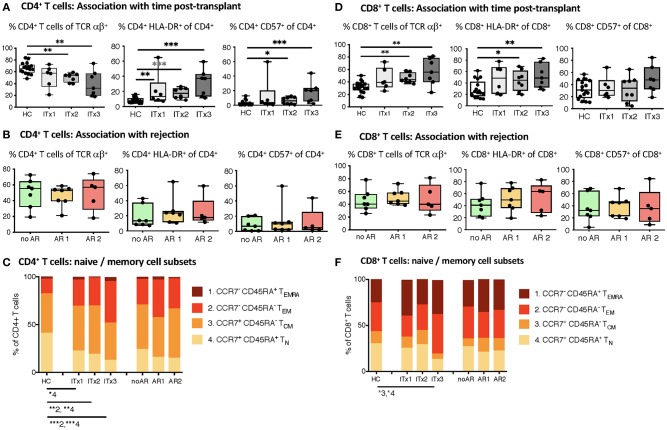
Comparative analysis of αβ T cell memory differentiation and expression of activation markers measured by flow cytometry. Shown are proportions as boxplots (median and minimum to maximum) of total, activated HLA-DR or CD57 expressing CD4+
(A,B) and CD8+ αβ T cells (D,E) as well as their CD45RA+CCR7+ naïve (1, TN), CD45RA−CCR7− central memory (2, TCM), CD45RA−CCR7− effector memory (3, TEM), and CD45RA+CCR7− terminal differentiated effector memory (4, TEMRA) subpopulations (C,F) measured in whole blood samples from intestinal transplant patients separated according to time post-transplant (ITx = 0–4 years, n = 7; ITx=4–10 years, n = 8; ITx > 10 years, n = 6) or occurrence of rejections (no AR = no rejection, n = 7; AR1 = acute humoral/mixed rejection, n = 7; and AR2 = acute cellular rejection, n = 5) and healthy controls. Statistical analysis was done using a Kruskal-Wallis-Test and Conover post-hoc test. *p < 0.05, **p < 0.01, ***p < 0.001.